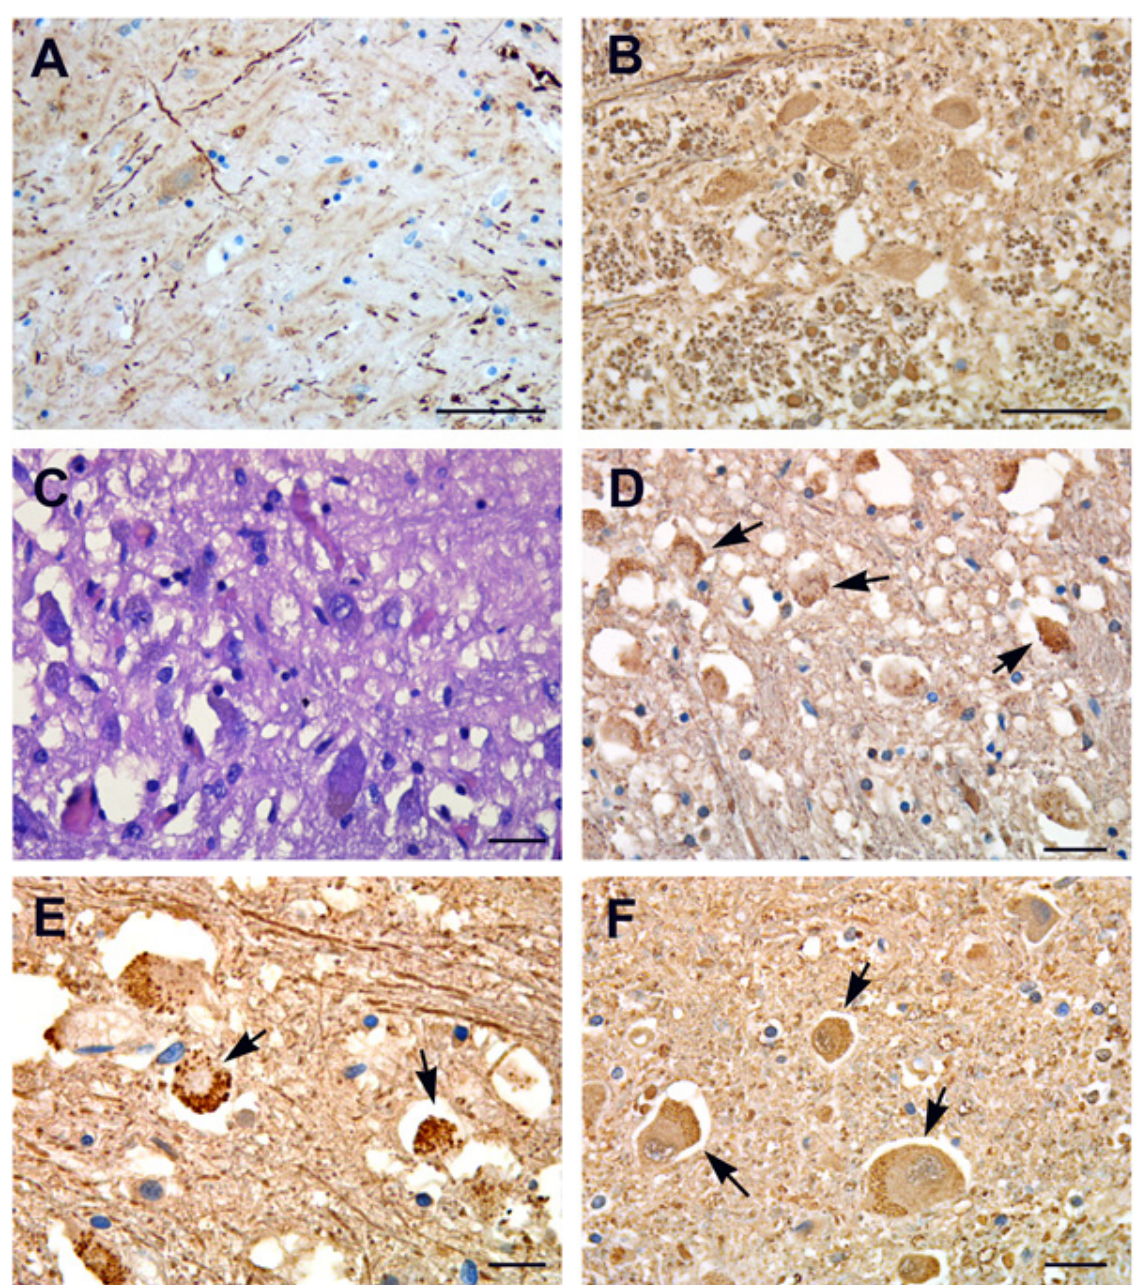
Figure 3. Neurofilament immunohistochemistry. ( A , B ) Neurofilament immunohistochemistry labels axonal spheroid, which are thick and curved axons showing axonal swelling and derangement of neuropil in basal nuclei ( A ) and in medulla oblongata ( B ). ( C ) H&E stained section showing axonal swelling and neuronal degeneration in pontine areas. ( D – F ) Anti-neurofilament immunolabeling of pons sections display the accumulation of small round granules in the cytoplasm of vacuolized neurons (arrows). Images from patients who did not have previous neurological deficits. Scale bars: ( A , B ) = 50 μ m; ( C , E , F ) = 7 μ m; ( D ) = 14 μ m.